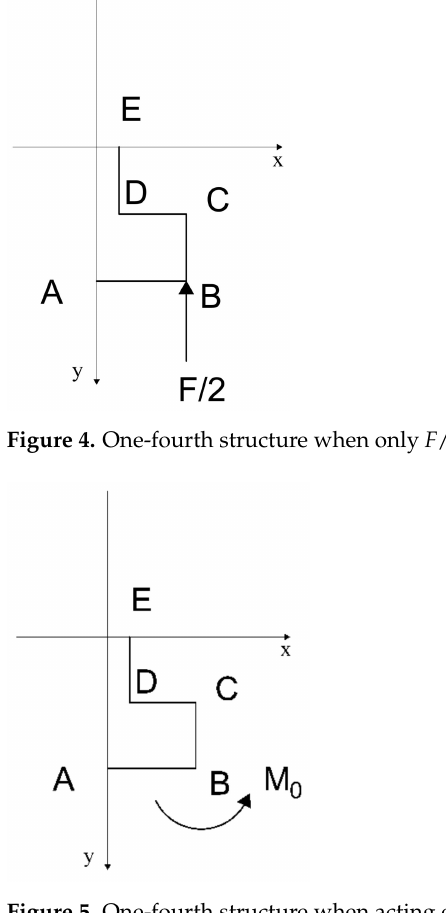
Figure 5. One-fourth structure when acting only on unit bending